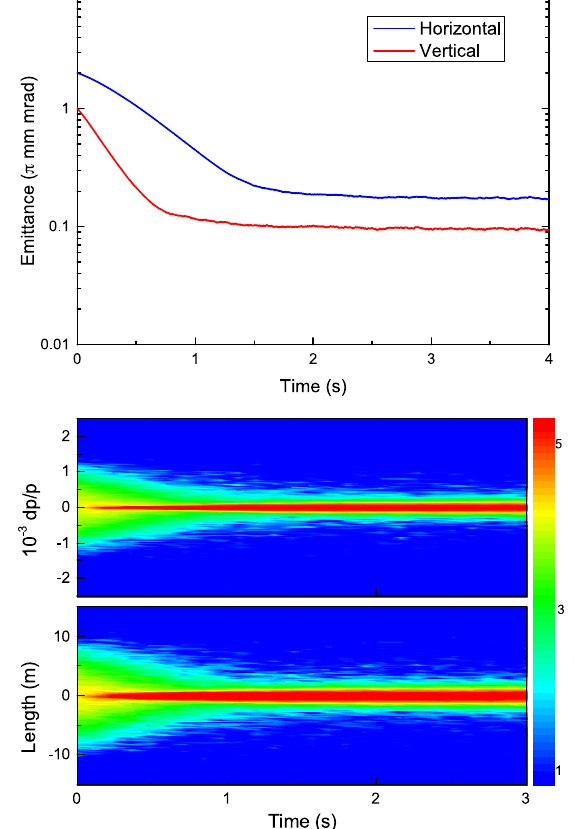
FIG. 2. Evolution of beam emittance (rms), distribution of momentum spread and bunch length in the procedure of cooling combined with rf field ( V